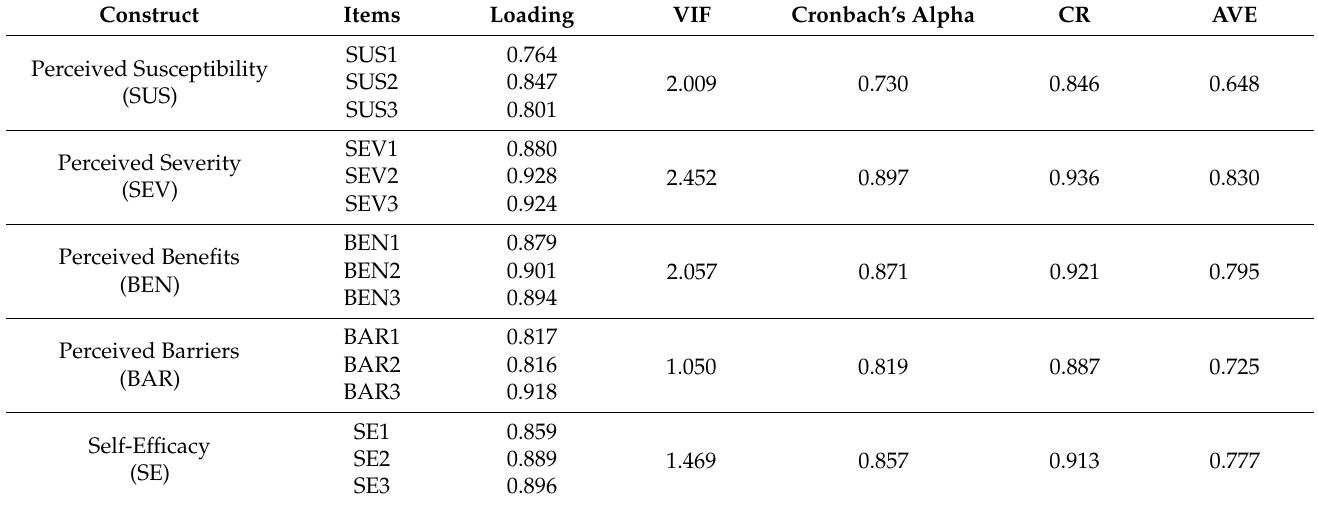
Table 2. Reliability and validity